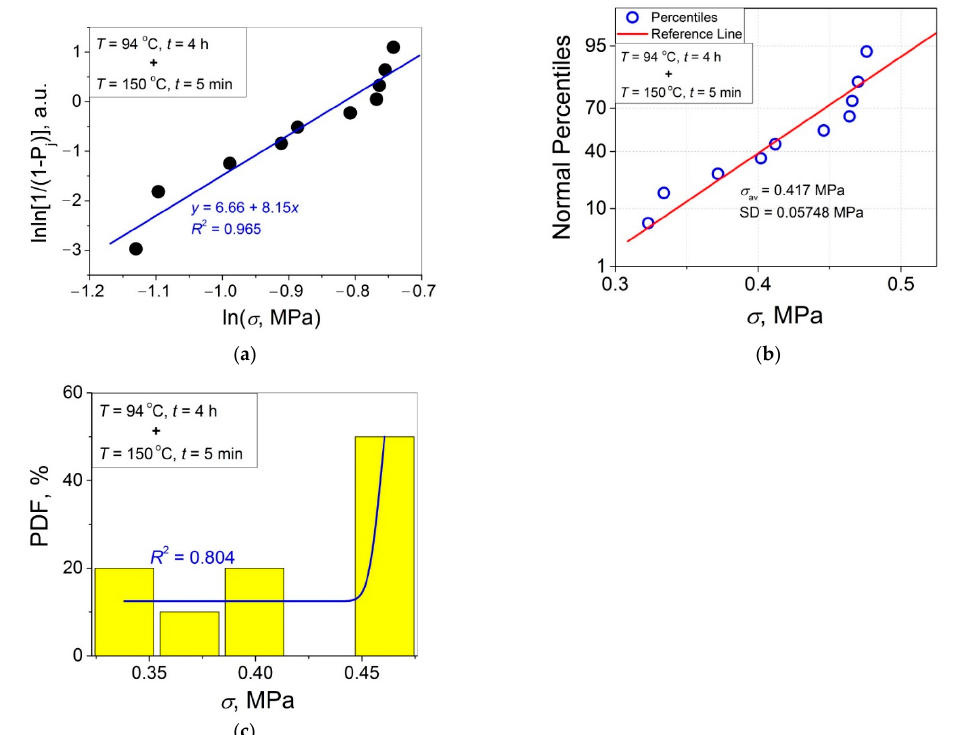
Figure 9. ( a ) Linear regression fit of the lap shear strength σ in Weibull’s coordinates; ( b ) normal probability plot; ( c ) probability density function (PDF) vs. σ fitted with a Gaussian function for an amorphous PET–PET interface self-bonded at T = 94 °C for t = 4 h and at T = 150 °C for t = 5 min.